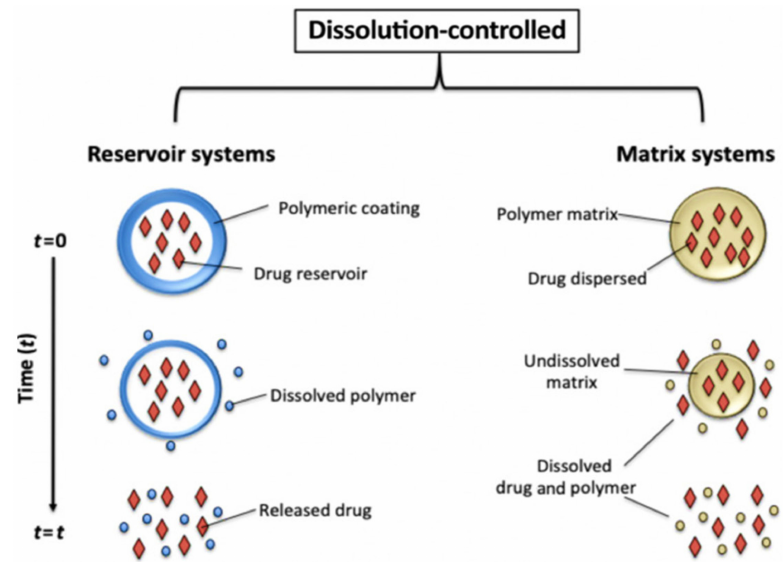
Figure 23. Dissolution-controlled delivery